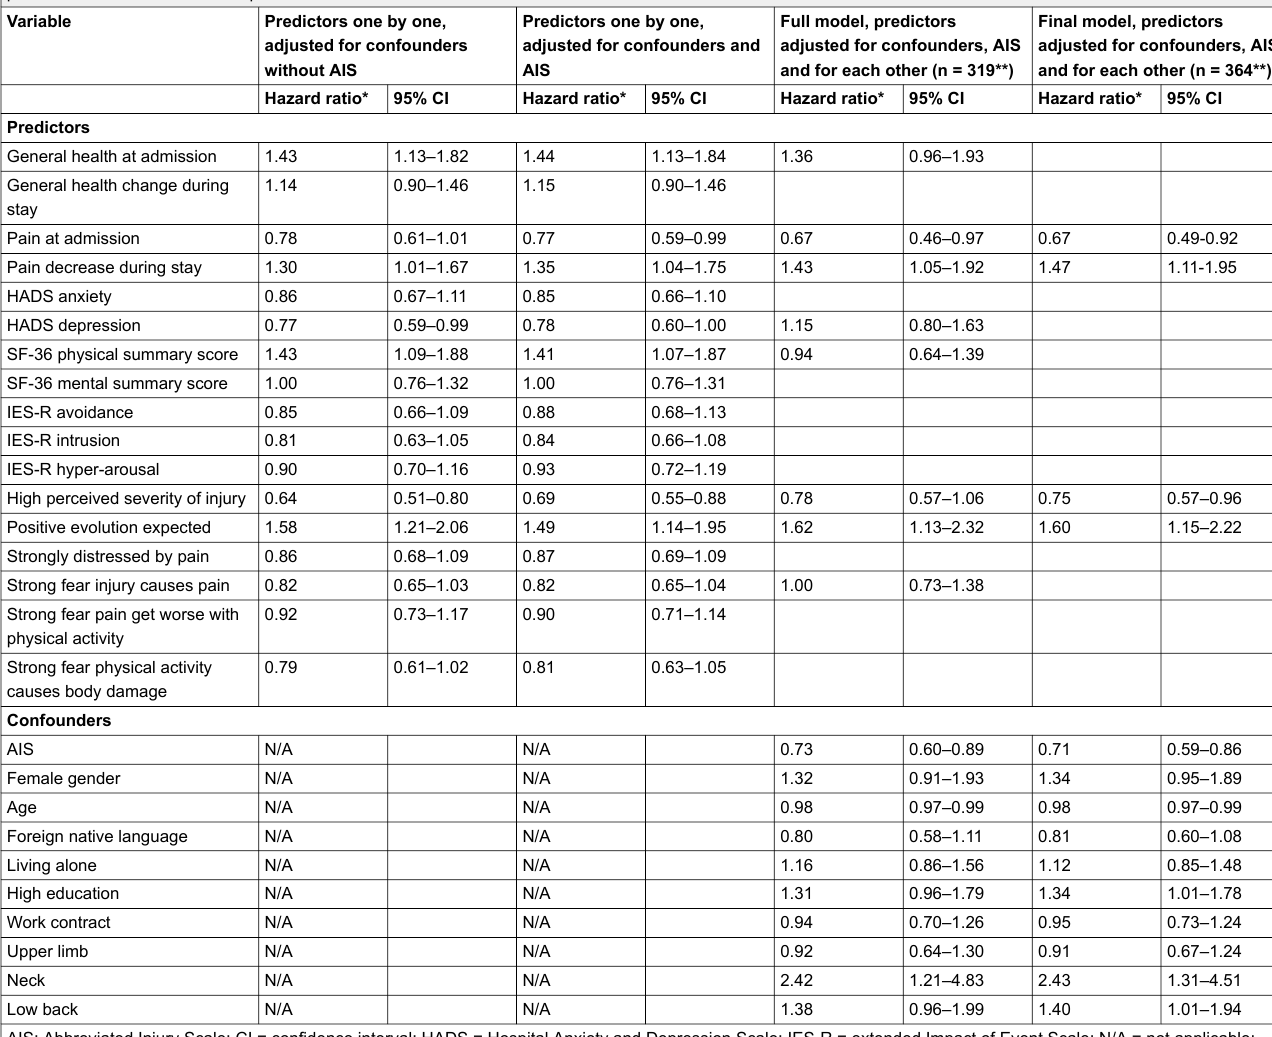
Supplementary table S1 : Cox models for time to fitness for work in the subpopulation where Abbreviated Injury Scale scores were available. A backward selection procedure was followed to end up with the final